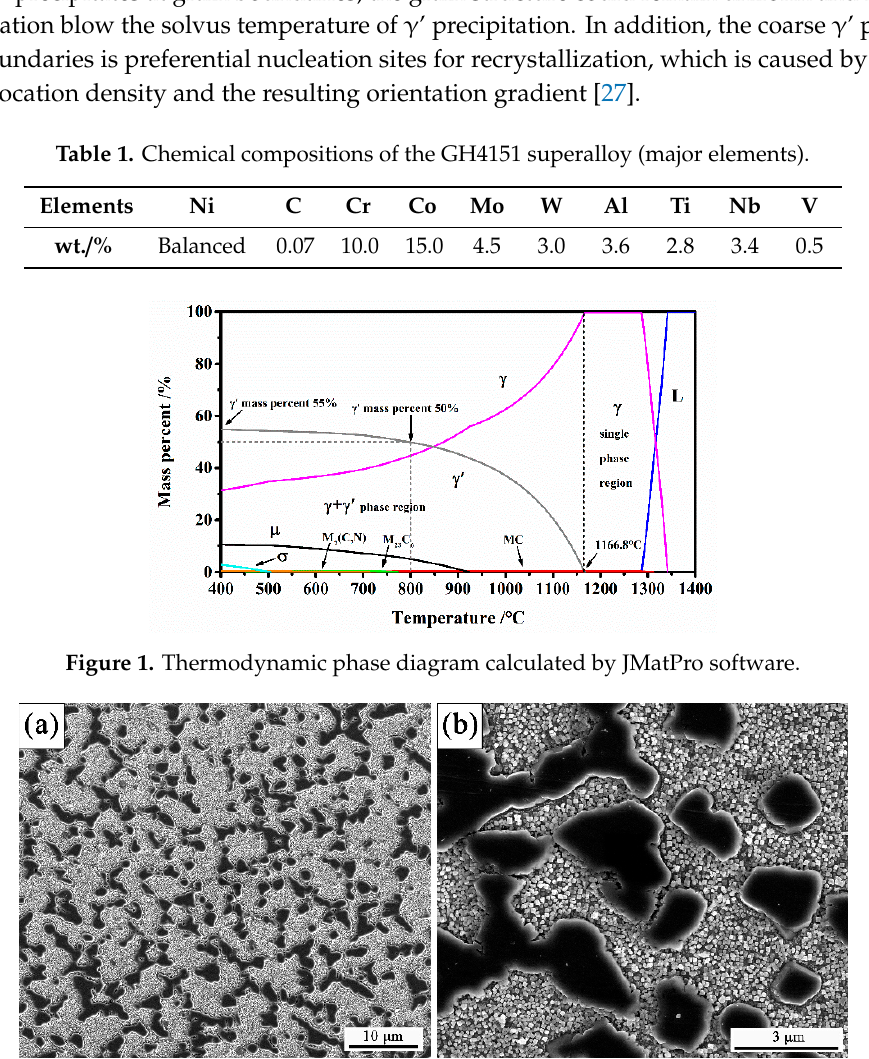
Figure 2. ( a,b ) The initial microstructure of the hot-extruded GH4151 alloy.